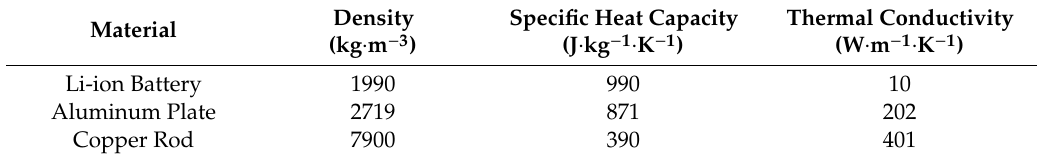
Table 3. Simulation parameters in this paper.